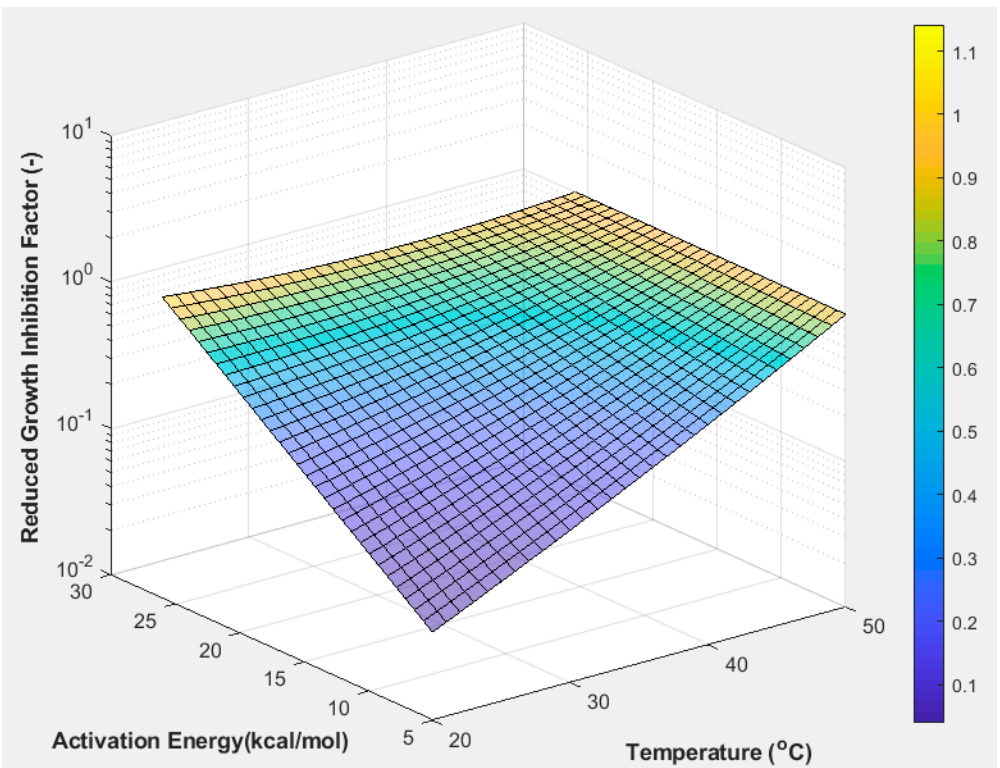
Figure 9. Computation of WC reduced growth inhibition factor in expected ranges for E a , and temperature for A.